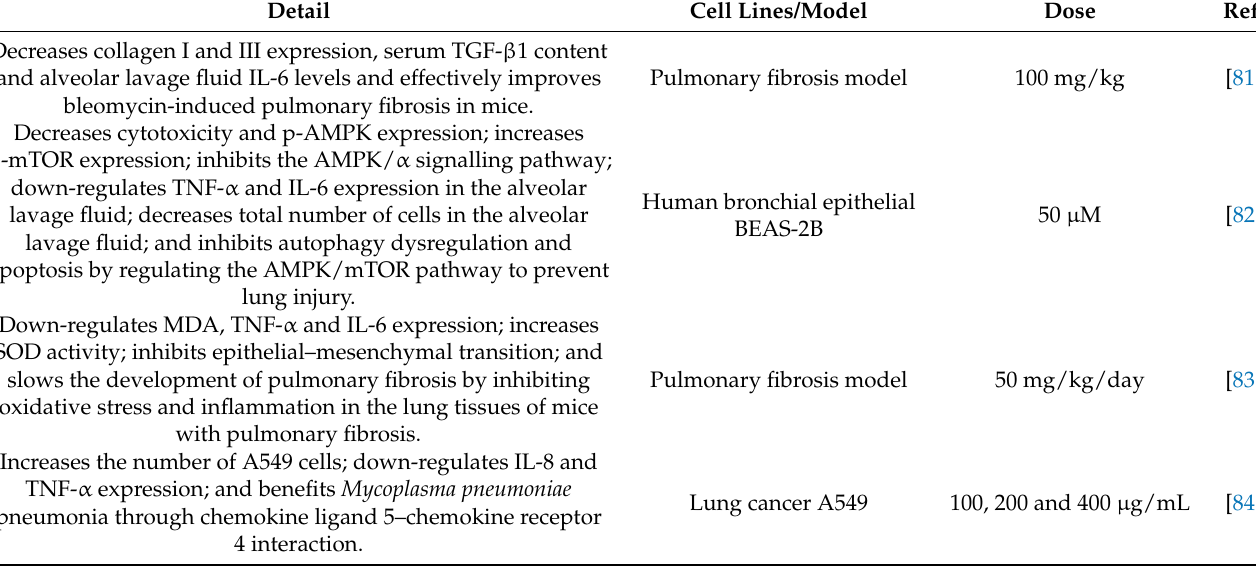
Table 7. Lung-Protective Activity of